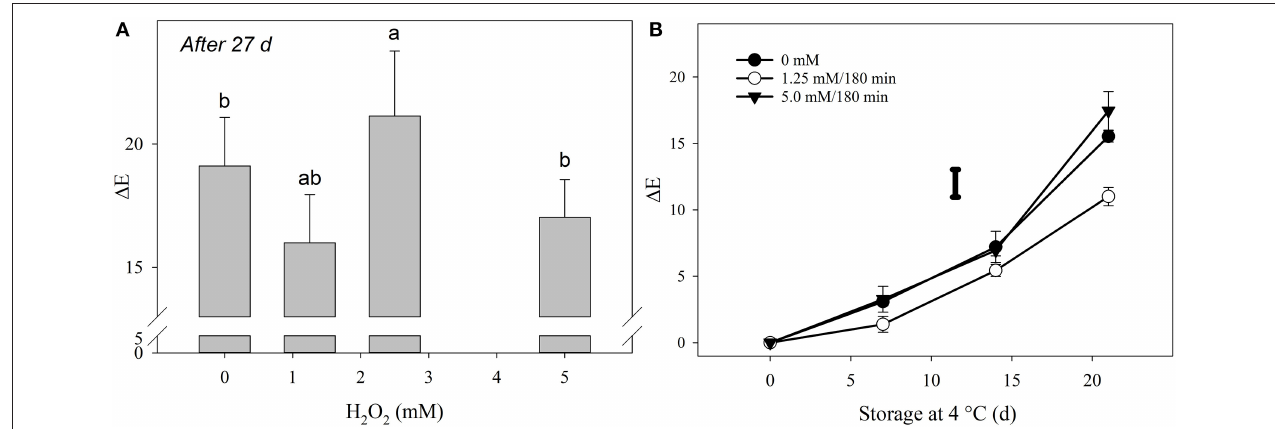
FIGURE 2 | Determination of the total color change in broccoli florets exposed to H 2 O 2 . (A) Hormetic dose determination based on total color change ( 1 E) of florets stored at 27 d at 4 ◦ C/90–95% using four different H 2 O 2 doses with 9 replicates per treatment ( n with different letters. (B) Total color change ( 1 E) of (•) untreated florets; treated with ( of 90–95%. Bars are the means of 9 repetitions per treatment ( n performed 6h after the end of the treatments.